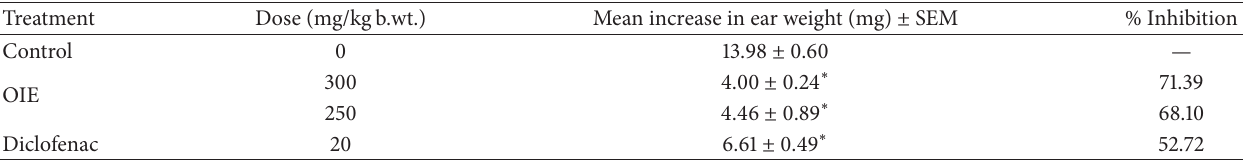
Inhibition ( % ) is shown in brackets. 𝑁 = 10 . Table 4: Effect of ethanol extract of Oroxylum indicum on xylene-induced ear edema in mice. Treatment Dose